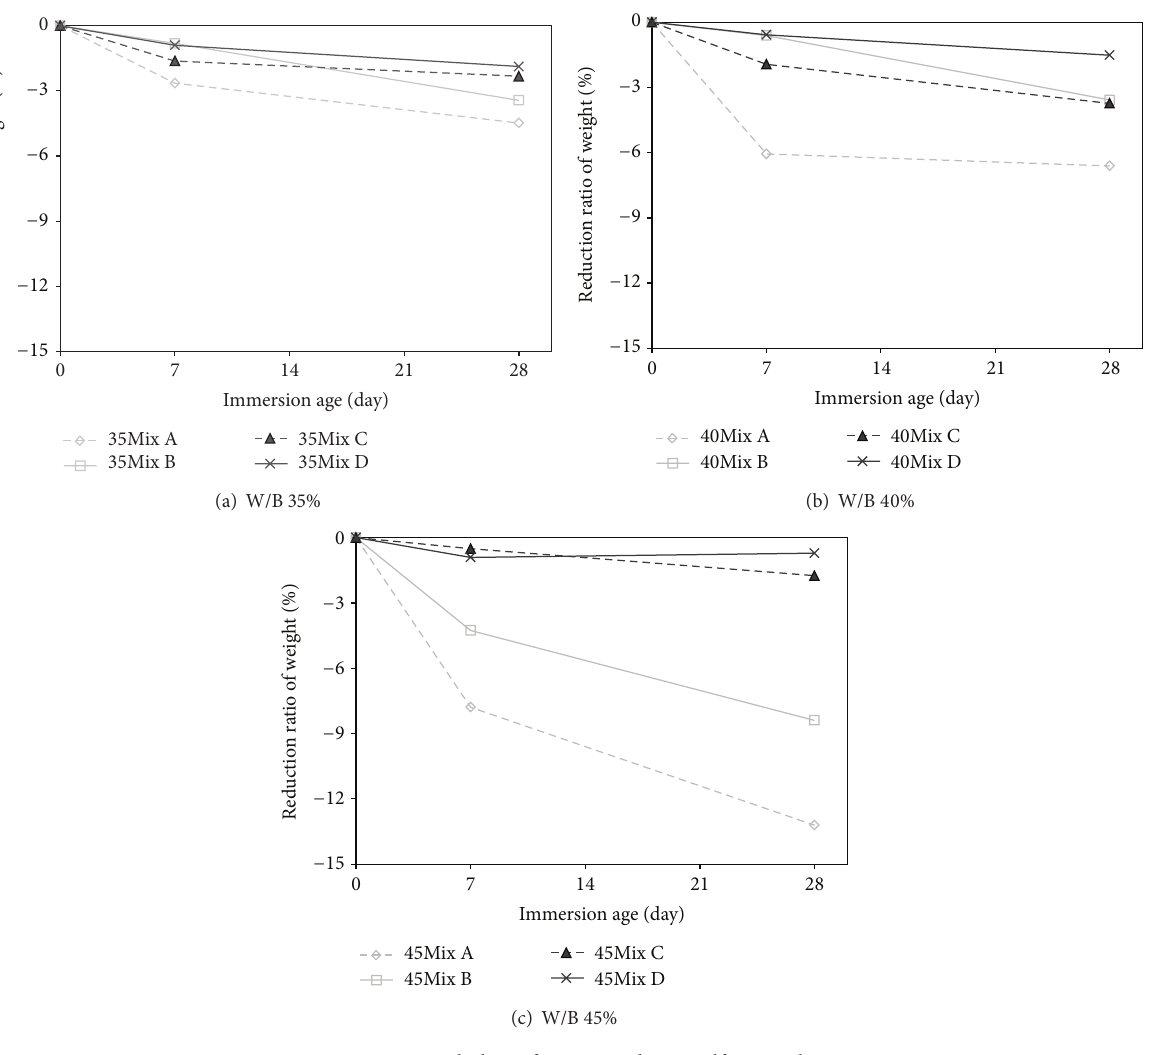
Figure 11: Weight loss of concretes due to sulfate attack.